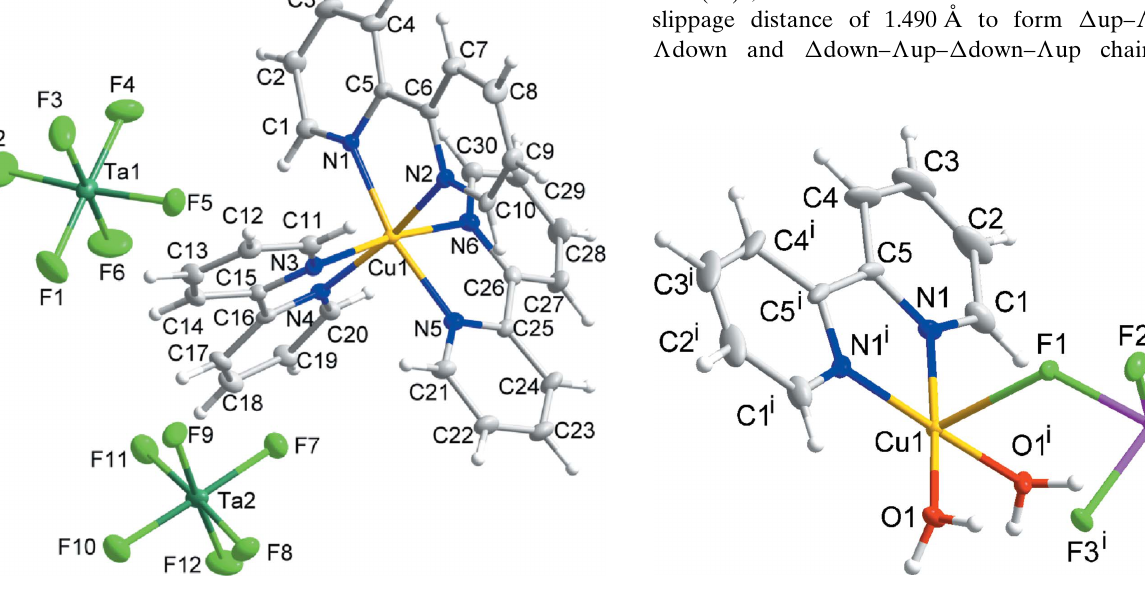
Figure 4 The molecular structure of (IV). Ellipsoids of non-H atoms are drawn at 50% probability. H atoms are drawn with an atomic radius of 0.135 A˚ . (cid:3) x , y , 3 (cid:3) z .] [Symmetry code: (i) 1 2 2